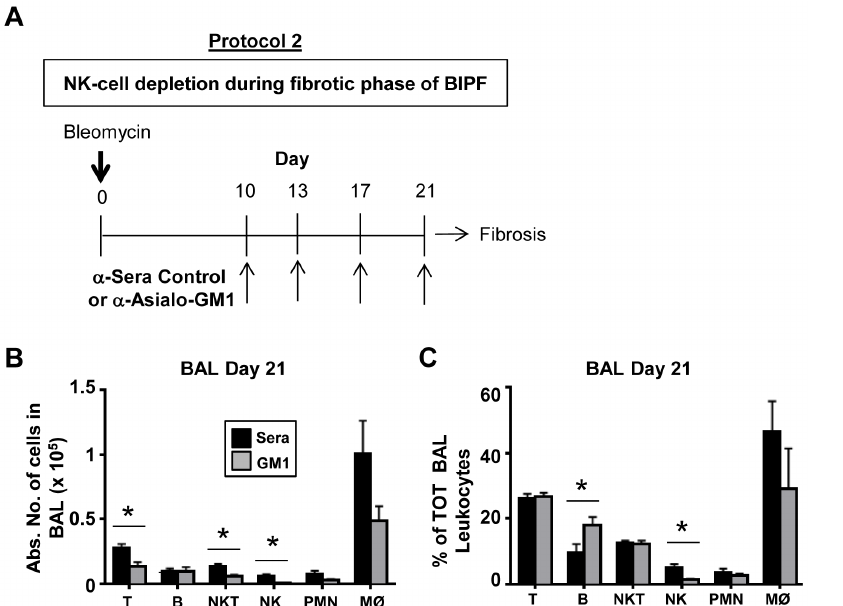
Figure 7. Anti-asialo GM1 treatment during the fibrotic phase of BIPF results in NK cell depletion. A ) Protocol 2 : depicts the treatment of mice with either isotype control or anti-asialo GM1 antibody to deplete NK cells during BIPF. Mice were given four injections of depleting antibody or control sera control at the indicated times after i.n. bleomycin dosing, starting on day 10. On day 21 after bleomycin injection, leukocytes were isolated from BAL fluid and stained with specific antibodies against NK cells (DX5) T-cells (TCR b ), B-cells (CD19) and NKT (TCR b + , DX5 + ), neutrophils (Ly6G), macrophages (F4/80) and analyzed by flow cytometry. The results are either expressed as absolute number of cells ( B ) or as a percentage of the total leukocytes ( C ). Mean 6 SEM of n=5 mice per group. *p , 0.05, ** p , 0.01 by t